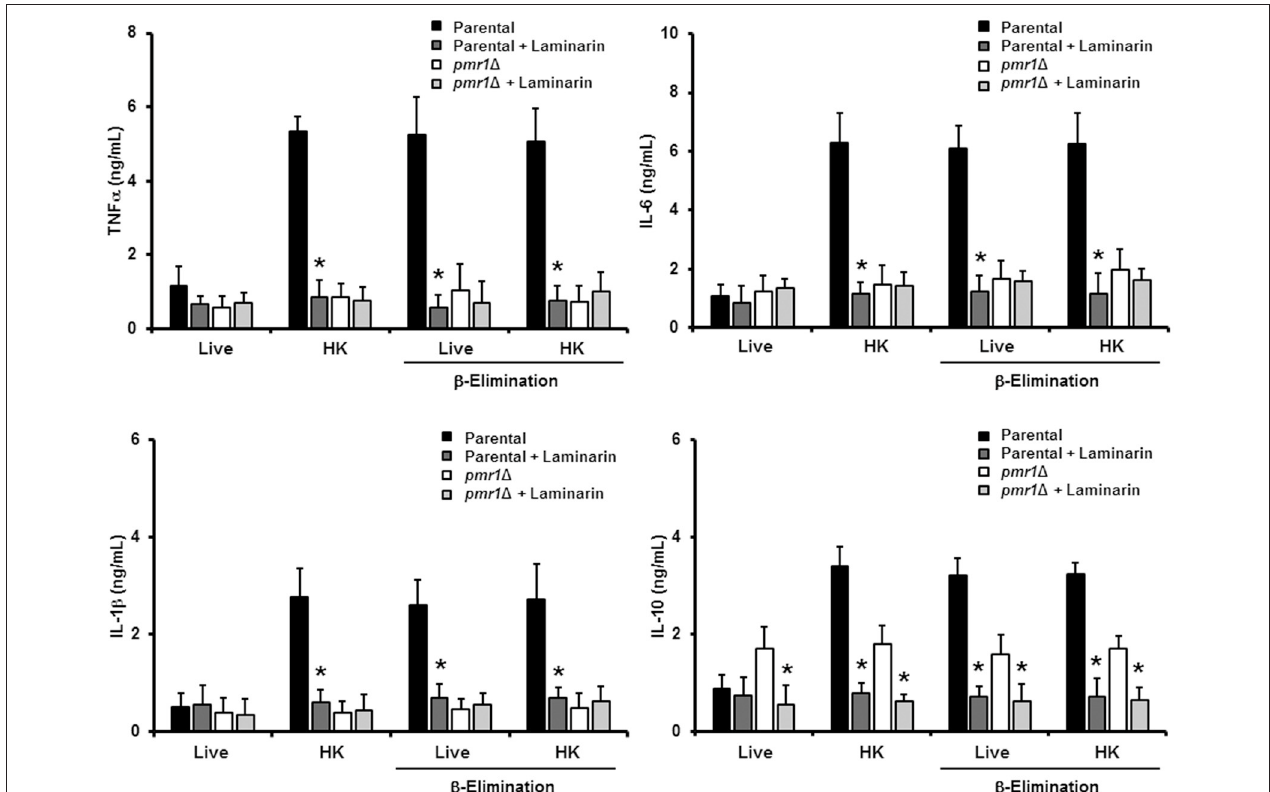
FIGURE 8 | Blocking of dectin-1 affects human PBMC cytokine induction in response to C. guilliermondii . Human PBMCs were pre-incubated with laminarin for 1h at 37 ◦ C prior to co-culture with yeast cells. After 24h incubation at 37 ◦ C, the supernatants were saved and used to quantify cytokine levels. Results (means ± SD) were obtained using samples from six donors, each assayed in duplicate wells. The strains used are: KU141 (Parental) and HMY134 ( pmr1 1 ). * P < 0.05, when compared to the same yeast cell type without